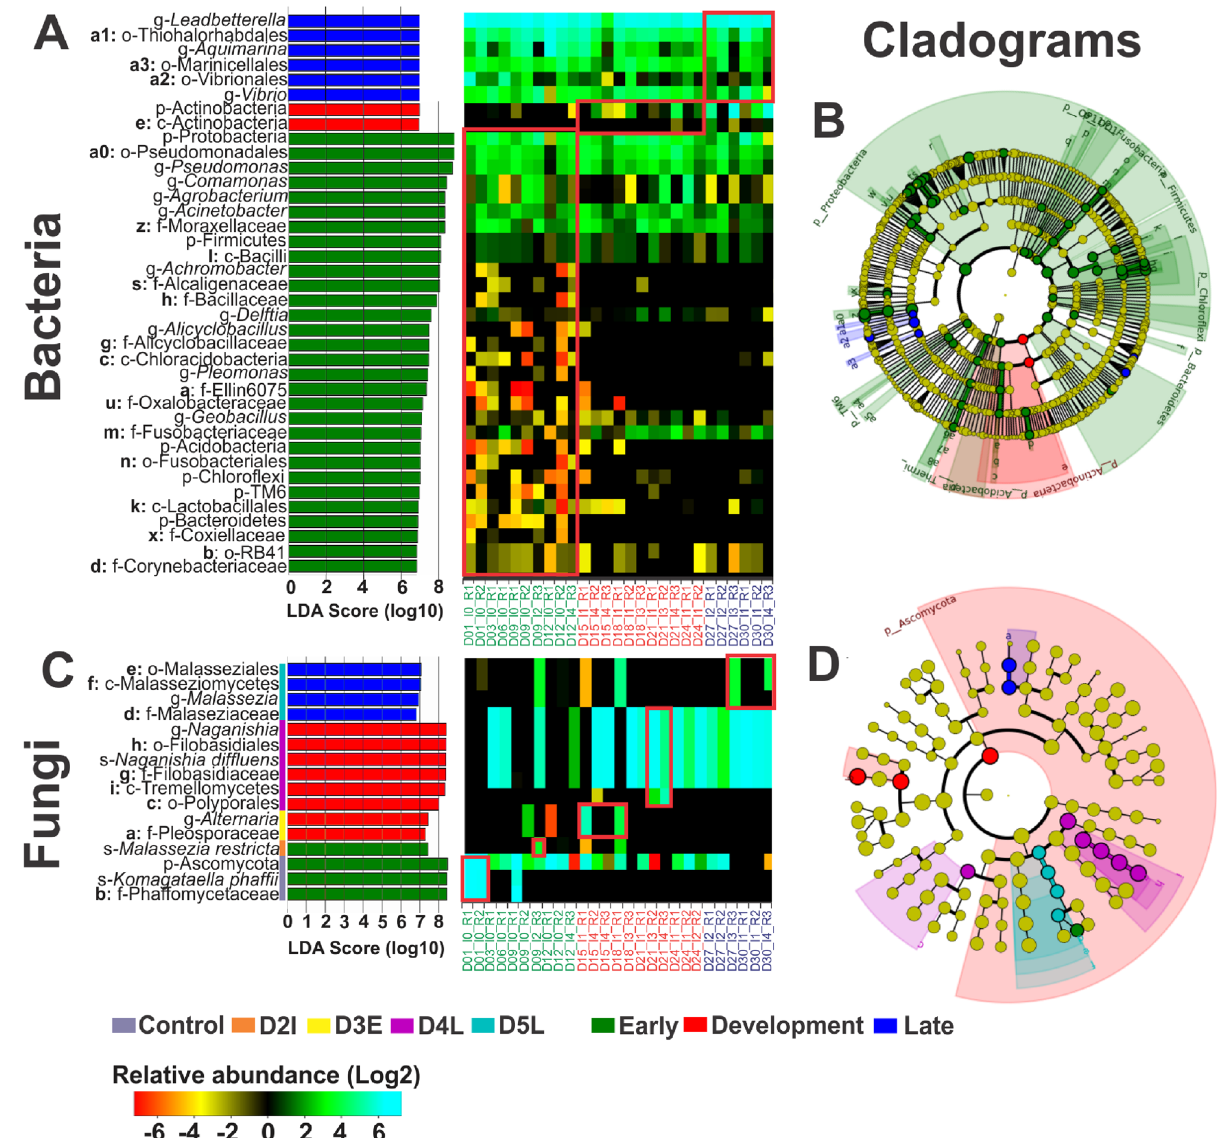
Figure 5. LEfSe results for enriched taxa of shrimp at early, development a late stage of the disease. Differentially expressed taxa visualized together with heatmap and cladogram graph for bacteria ( A , B ) and fungi ( C , D ), respectively. Differentially expressed taxa shown as log10 LDA score for each disease classification. Heatmaps using Log2 transformed relative abundance were used to cluster (x axis) genera by disease stage (early in green, development in red and late in blue). Red squares highlight the differentially expressed taxa in each disease stage condition. Cladograms represent the phylogenetic relation between microorganisms detected at the different disease stages and are marked with a bold alphabetical letter to locate the name of the taxa in the log10 LDA score graph. The heatmaps color key ranges from orange for low abundant (< 1%) microorganisms to cyan for high abundant microorganisms (1–90%). The top 30 overrepresented taxa are shown. Letters p- (phyla), c- (class), o- (order), f- (family) and g- (genera) on the left side of the taxa name represent the group level. For fungi, a subgroup of disease-stage was used: control and D2I from the early-stage, D3E and D4L for the development-stage and D5L for the late-stage. For fungi, subgroups of disease-stage were used: control, D1N, D2N, D2I for early-stage, D3E D3L, D4E and D4L for development-stage and D5E and D5L for